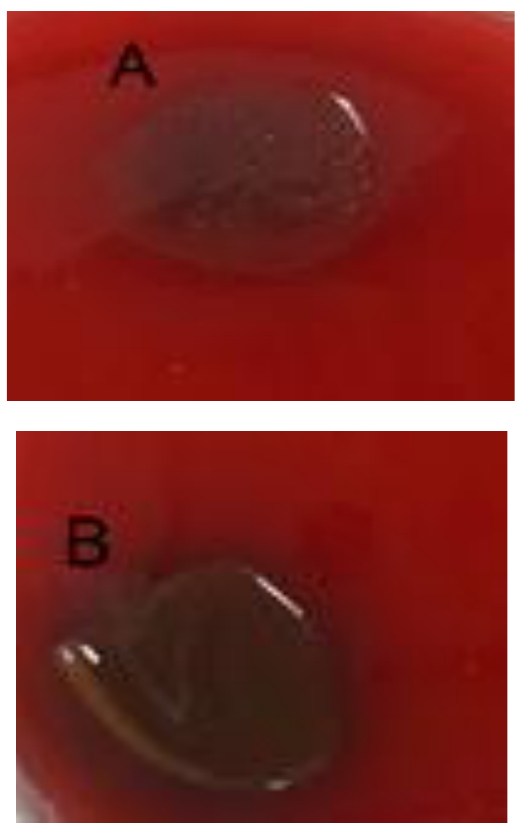
Fig. 10. Hemolysis effect of thin films (A) without and Figure 10. Hemolysis effect of thin films (A) without and (B) with nanofiber on blood agar medium (B) with nanofiber on blood agar medium